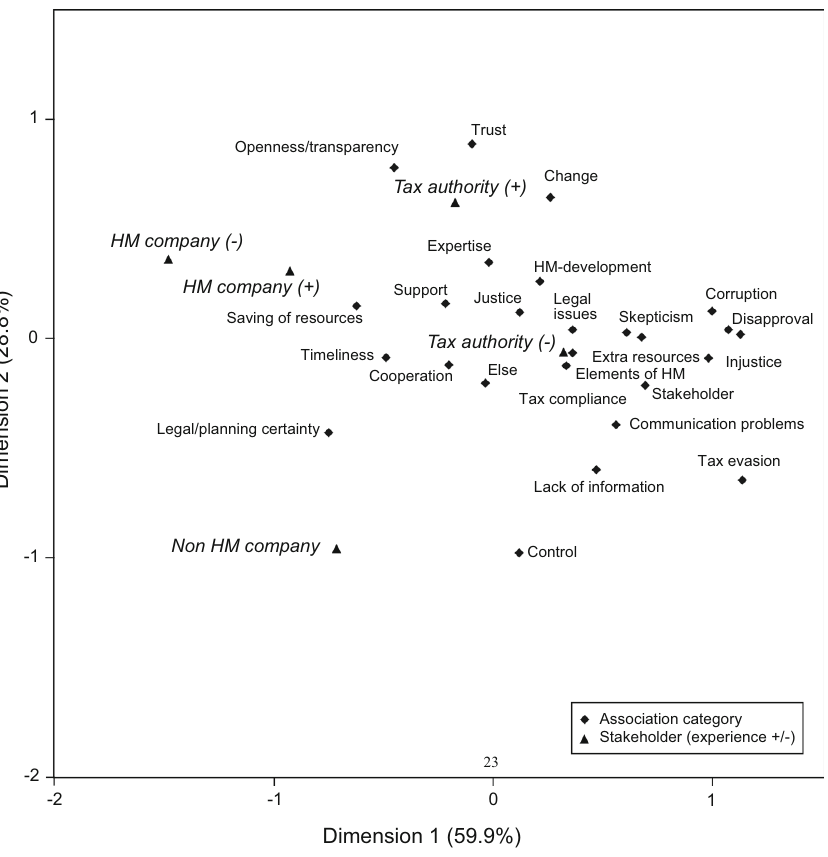
Fig. 1 Two-dimensional solution of correspondence analysis of free association categories by stakeholder